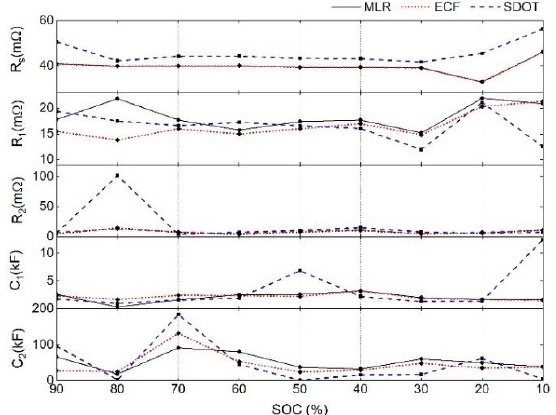
Figure 9. The estimated parameters of the second-order RC ECM for MLR (solid), ECF (dashed) and SDOT (dotted). The symbols represent the experimental data and the lines are the linear interpolation of the experimental data.